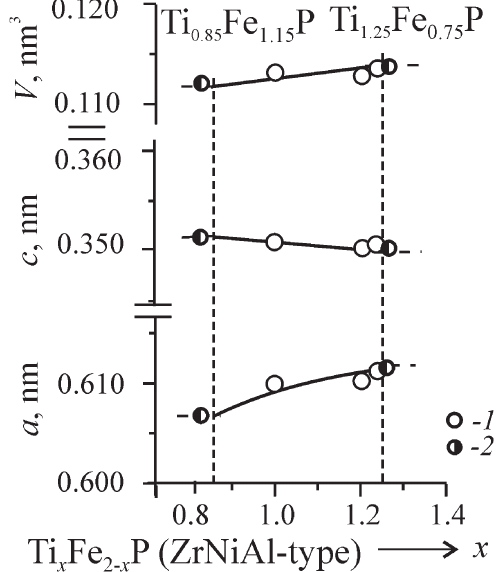
Figure 5. Dependence of the lattice parameters and the unit cell volume V of Ti Fe P compound vs. the 0.85-1.25 1.15-0.75 concentration of Fe (1 – single phase; 2 – two phases).